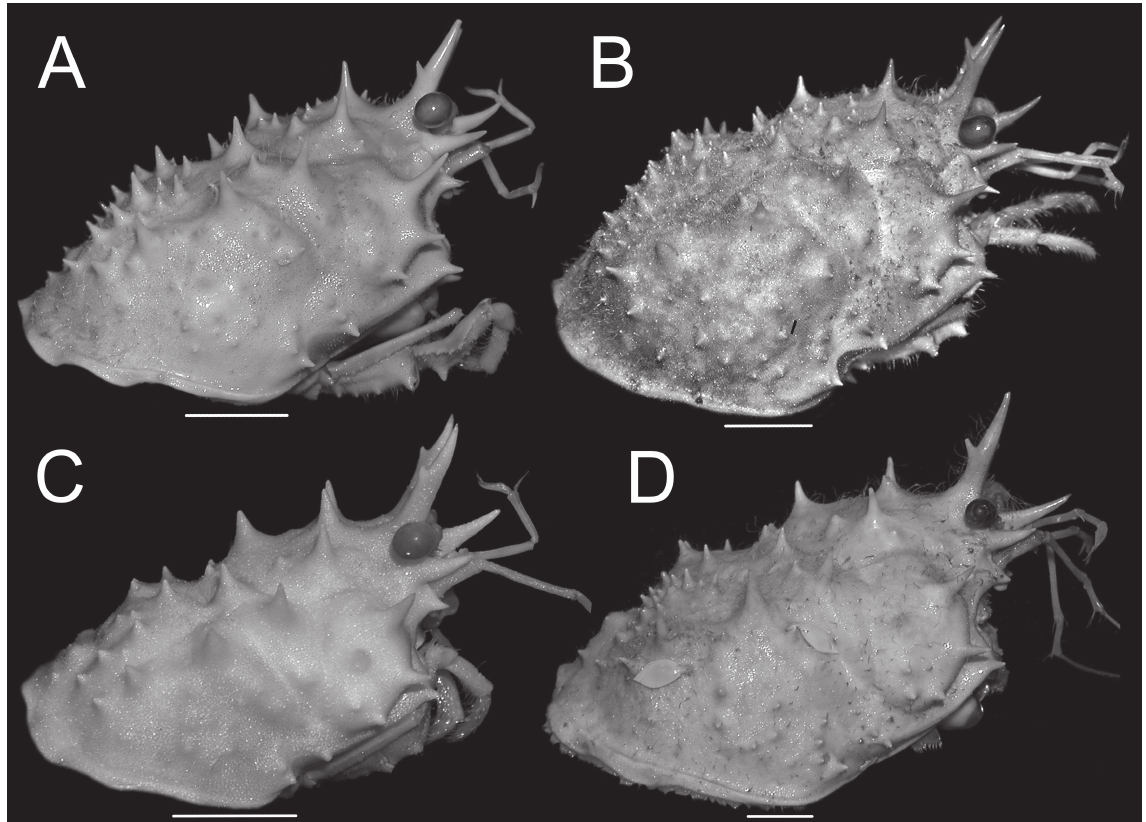
Fig. 5. Lateral view of cephalothorax. A . Moloha grandperrini Guinot & Richer de Forges, 1995. Holotype, ♂ (cl 46.5 mm, cw 39.0 mm) (NHM 1948.9.7.27), Maldives. B . Moloha tumida sp. nov. Holotype, ♂ (cl 55.7 mm, cw 50.6 mm) (DABFUK), Kerala, India. C . Moloha alisae Guinot & Richer de Forges, 1995. Holotype, ♂ (cl 36.1 mm, cw 29.7 mm) (MNHN-IU-2008-11077), Seychelles. D . Moloha alisae Guinot & Richer de Forges, 1995. ♂ (cl 67.7 mm, cw 56.2 mm) (ZRC 2008.1250a), South Africa. Scale bars = 10